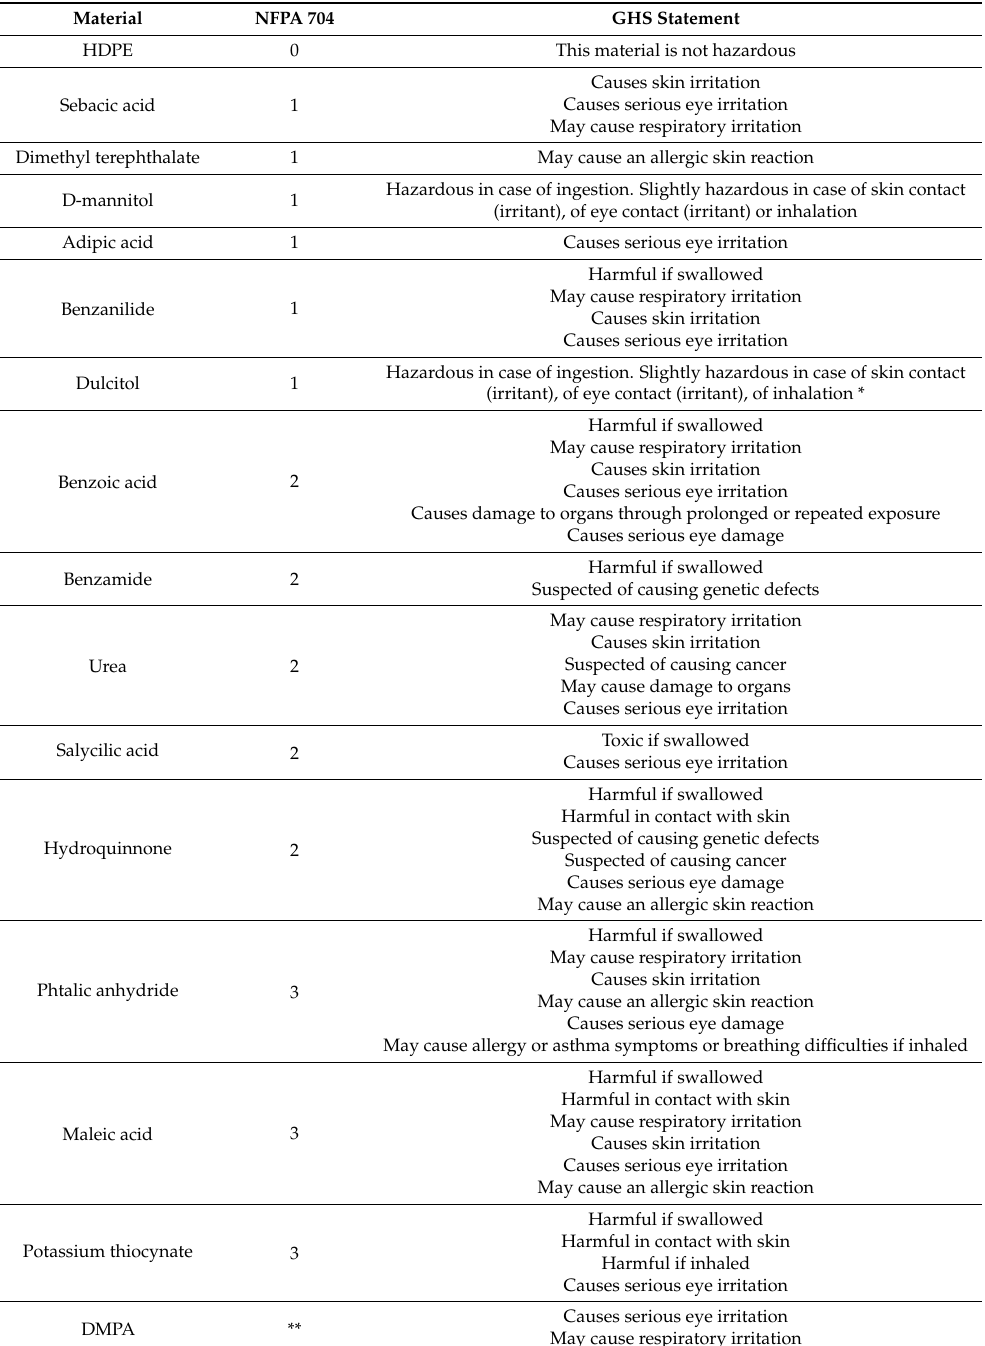
Table 3. Safety and health hazard information of the PCMs under study